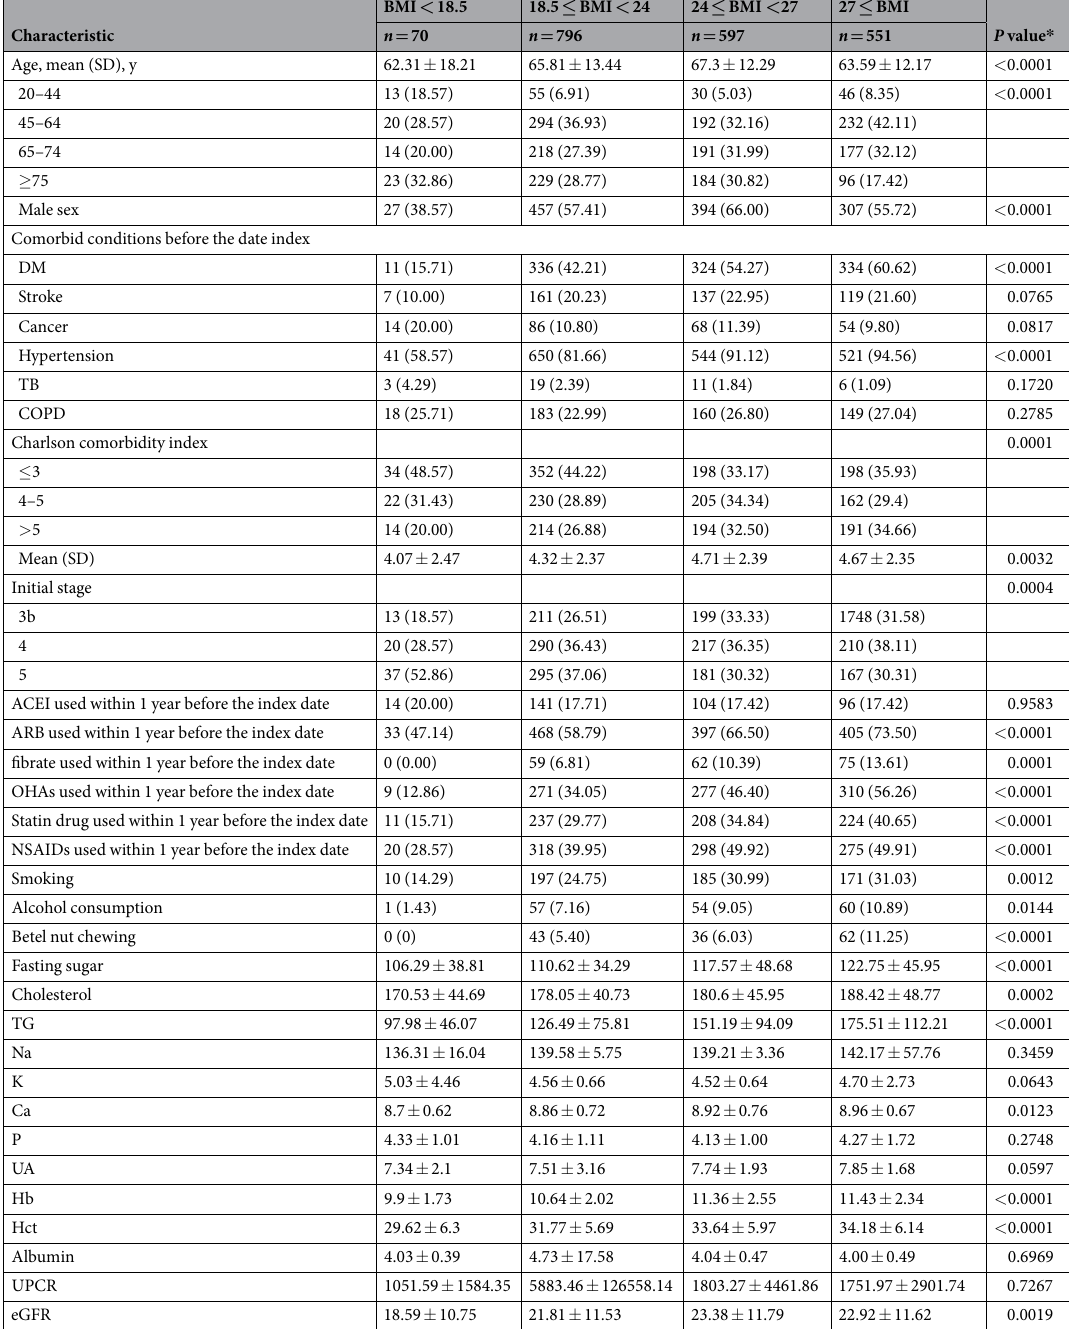
Table 3. Baseline characteristics of CKD stages 3b-5 according to different BMI. * Categorical variables: chi- urine albumin; Hb, hemoglobin; Hct, hematocrit; UPCR, urine protein-to-creatinine ratio; eGFR, estimated glomerular filtration